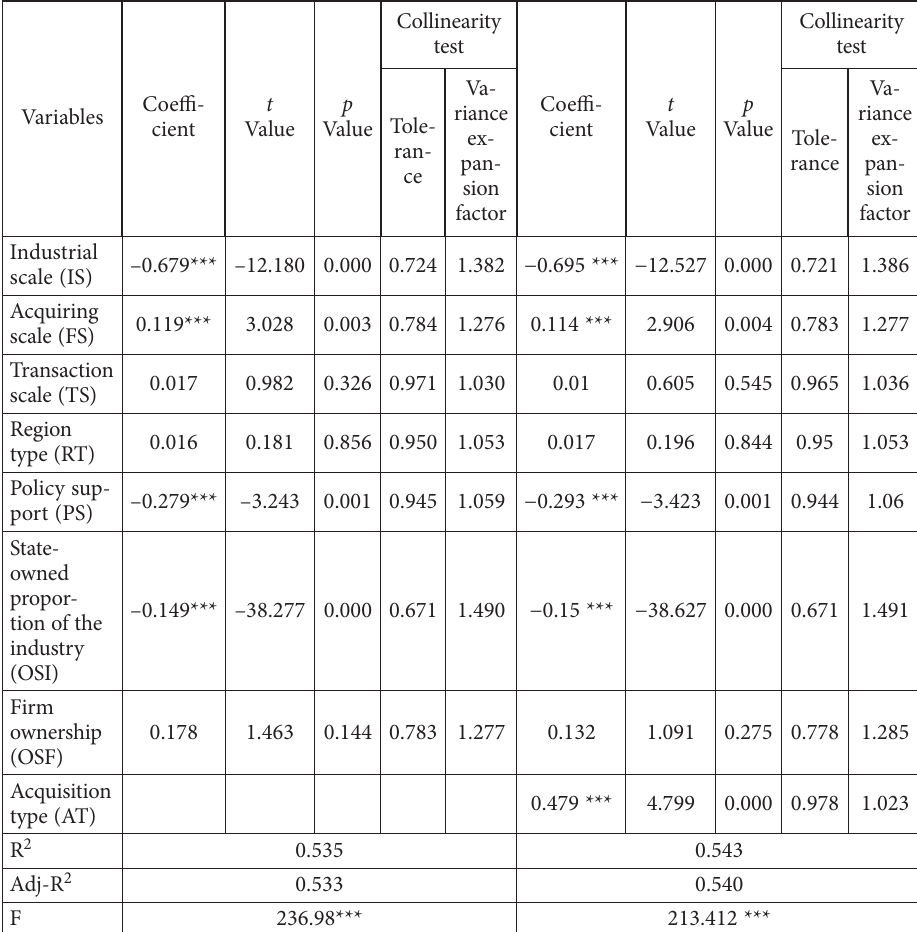
Table 4. Regression analysis results of the impact of acquisition type on industrial